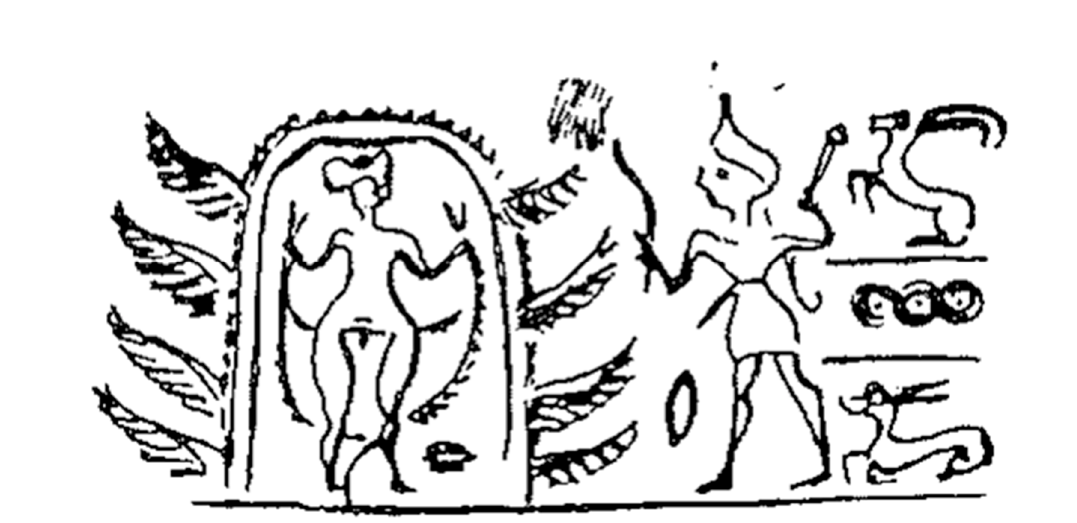
Figure 8. Syrian seal: Naked goddess in a winged structure and storm god (Amiet 1960: Figure